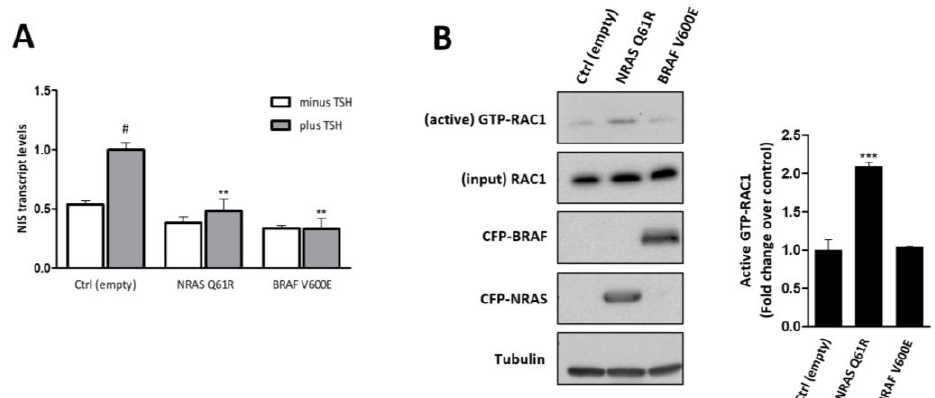
Figure 1. Effect of NRAS and BRAF gain-of-function mutants on NIS transcriptional expression in non-neoplastic, TSH- responsive thyroid follicular cell line. ( A ) PCCL3 cells were transduced with empty, NRAS Q61R or BRAF V600E constructs and subjected to a 24 h starvation period (minus TSH) followed by stimulation with TSH (1 mU/mL for 48 h plus TSH). NIS mRNA levels were quantified by RT-qPCR and plotted as fold differences relative to mock transfected [Ctrl (empty)] cells, treated with TSH. Values are the mean ± standard error of the mean (SEM) of five independent assays. One-way ANOVA analysis detected significant differences between the different conditions (F = 9.95; p < 0.001). Post-hoc Dunnett’s tests were used to identify significant variations from Ctrl (empty) conditions ( # p ≤ 0.05 relative to minus TSH; ** p ≤ 0.01 relative to plus TSH). ( B ) Endogenous RAC1 activation status in Ctrl (empty)-, NRAS Q61R- and BRAF V600E-expressing cells was assessed by monitoring the active, GTP-bound fraction of RAC1 by CRIB domain pull-down assay (quantified in the plot to the right; *** p ≤ 0.001 relative to ctrl [empty]). Total (input) and active RAC1 levels were assessed by western blot using anti-RAC1 primary antibody. NRAS and BRAF expression was detected using anti-GFP primary antibody. Alpha-tubulin was used as loading control (see Figure S3 for uncropped WB).